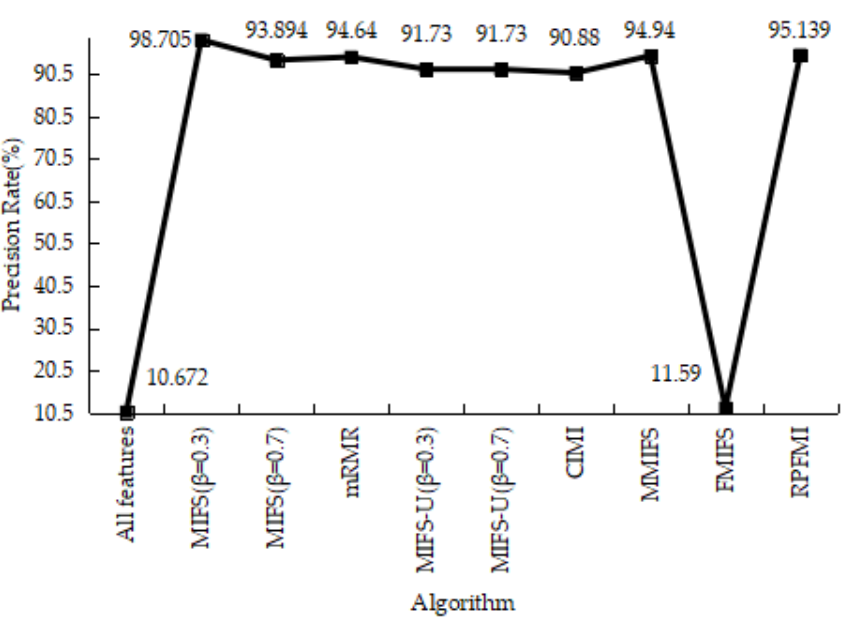
Figure 8. Precision Rate on the U2R test data.